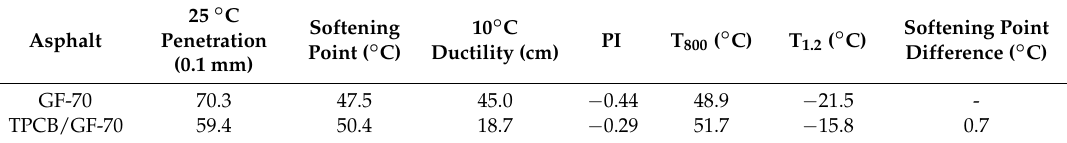
Table 4. Results of physical performance and segregation tests of GF-70 and